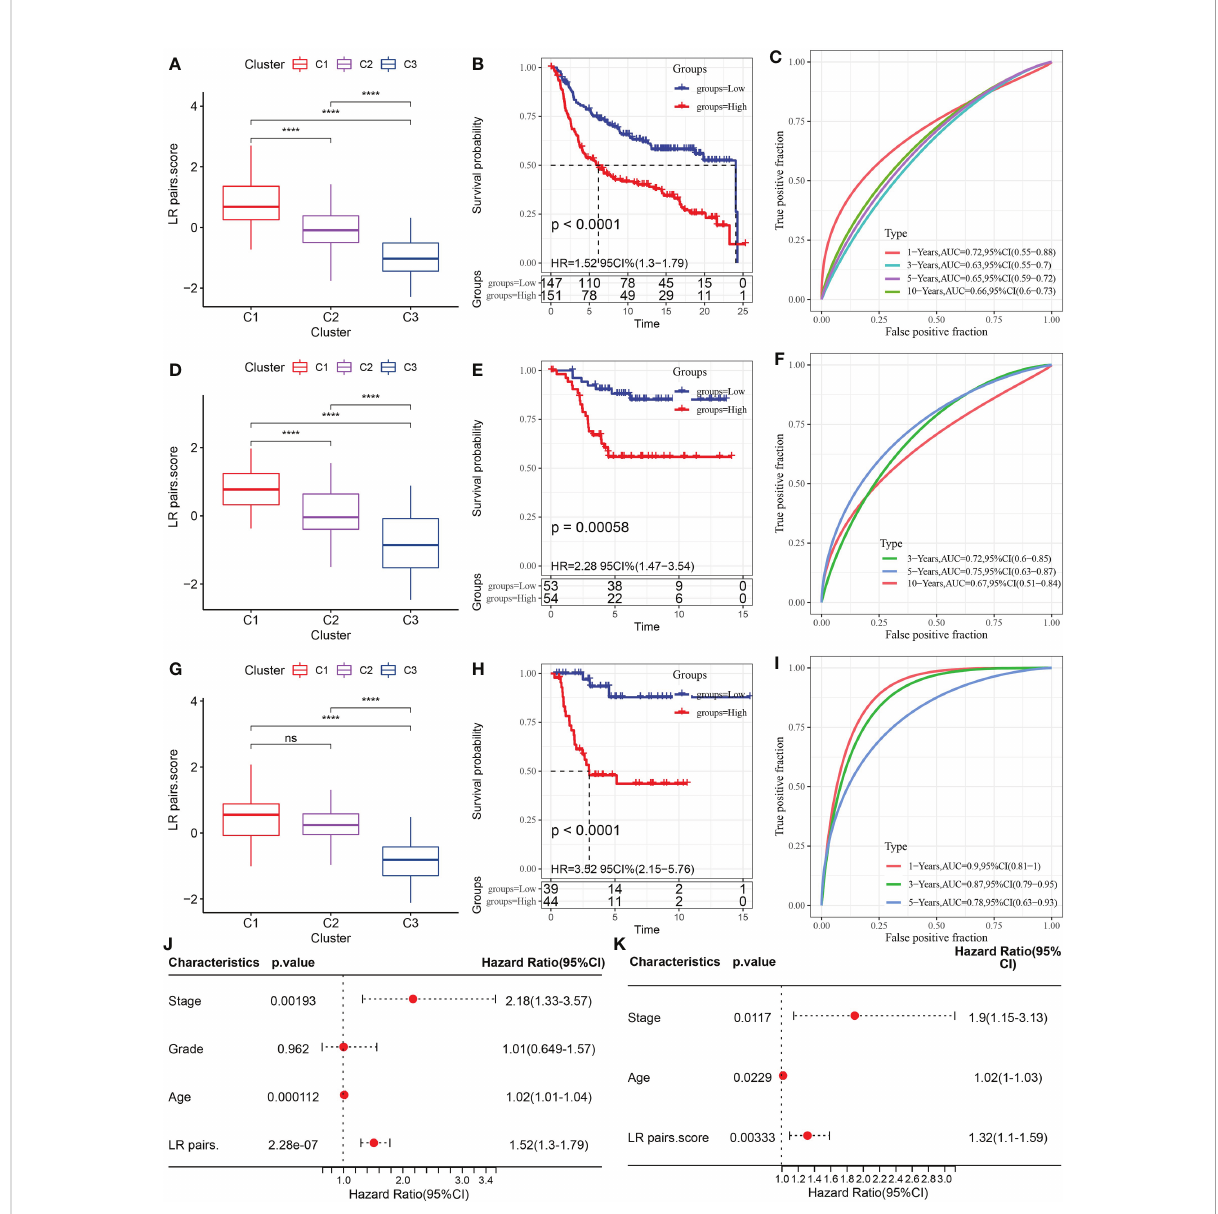
FIGURE 6 Construction and evaluation of LR pairs score model. (A) The box chart of LR pairs scores in three LR pair-based subtypes in the METABRIC cohort, Kruskal-Wallis test. (B) Kaplan – Meier estimates comparing OS of samples with distinct LR pairs score in the METABRIC cohort, Log rank test. (C) The time-dependent ROC curves showing the prognosis-predicting capacity of LR pairs score in the METABRIC cohort. (D) : The box chart showing LR pairs scores in different LR pair-based subtypes in the GSE58812 cohort, Kruskal-Wallis test. (E) Kaplan – Meier analysis of the LR pairs score model in the GSE5881cohort, Log rank test. (F) The time-dependent ROC curves showing the prognosis-predicting value of LR pairs score model in the GSE58812 cohort. (G) . The box chart of LR scores in different LR pair-based subtypes in the GSE21653 cohort, Kruskal- Wallis test. (H) Kaplan – Meier estimates comparing OS of samples with distinct LR pairs score in the GSE21653 cohort, Log rank test. (I) The ROC curves showing the prognosis-predicting capacity of LR score in the GSE21653 cohort. (J, K) The forest plots showing the coef fi cients and their con fi dence interval of the univariate and multivariate COX regression which included the factors of LR pairs score, patient age, stage, grade, and patient outcomes in the METABRIC. The asterisks represented the statistical p value, ns(no signi fi cance) ****p <